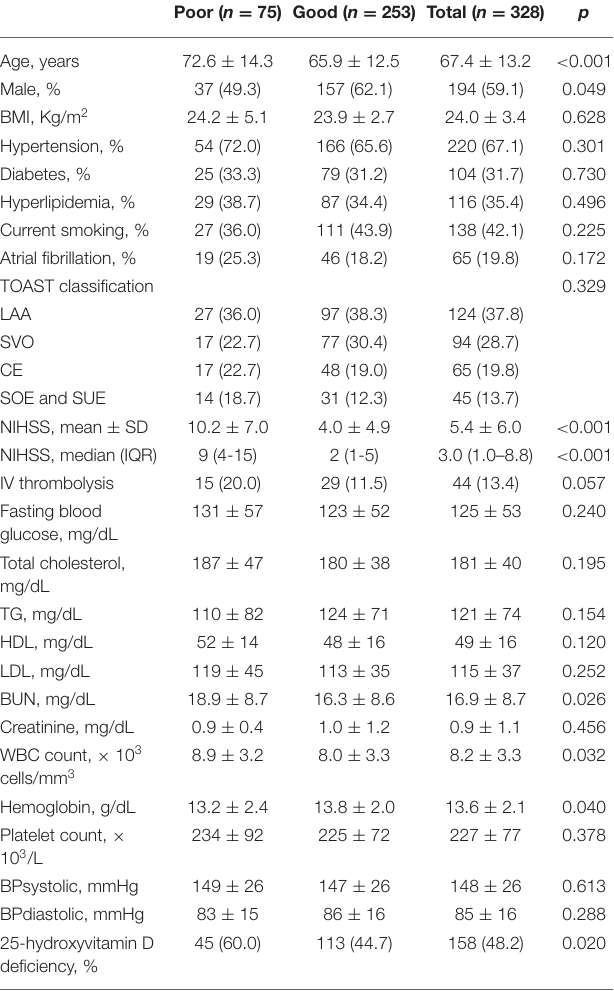
TABLE 2 | Differences of demographic and clinical characteristics between good and poor outcome groups of patients with acute ischemic stroke. Poor ( n = 75) Good ( n = 253) Total ( n = 328)